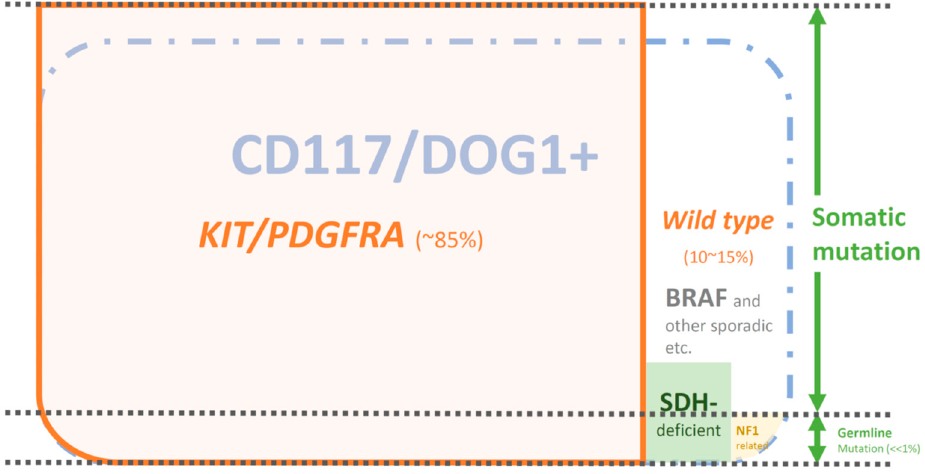
Figure 1. The overview of immunohistochemical staining and genetic analysis in gastrointestinal stromal tumors (GISTs). The blue dashed boundary indicates CD117/DOG1+ GISTs. The orange solid boundary indicates GISTs with KIT/PDGFRA mutations. The black dashed lines subgroup GISTs into somatic and germline mutations.